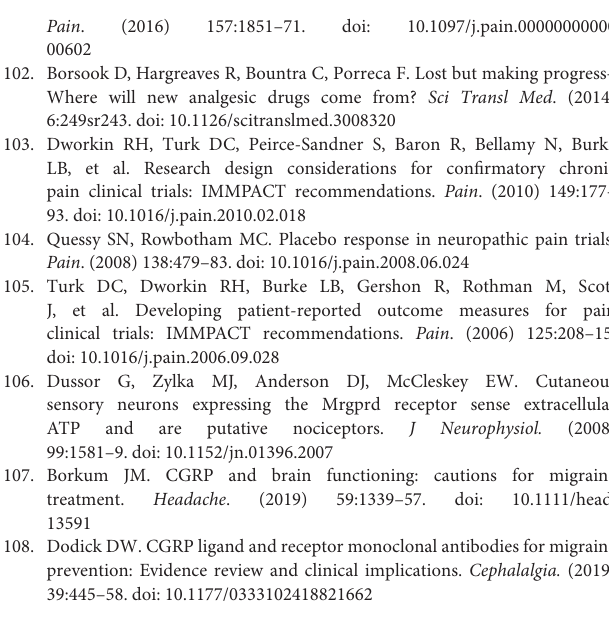
109. Edvinsson L. Role of CGRP in migraine. Handb Experi Pharmacol. (2019) 255:121–30. doi: